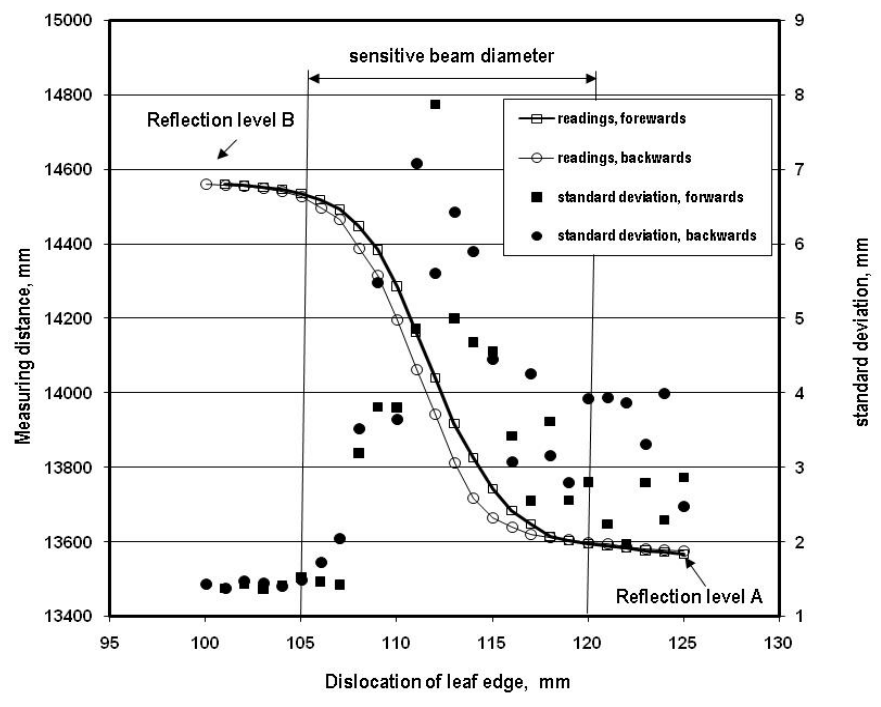
Figure 6. Distance readings of the laser rangefinder depending on leaf edge dislocation according to Figure